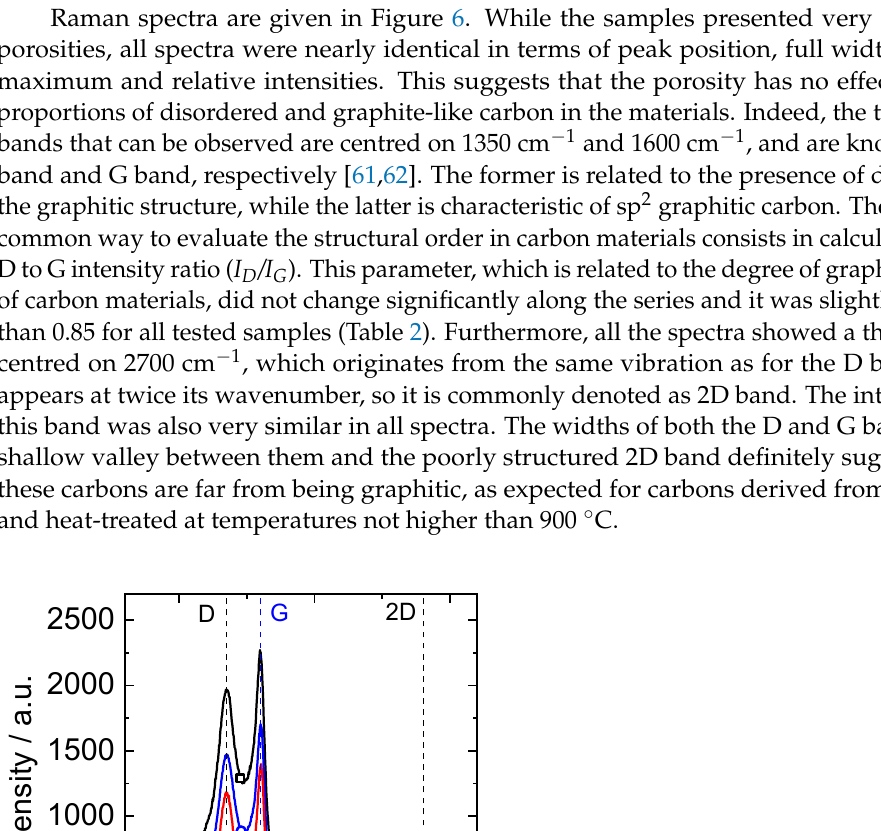
) and Young’s (cid:35)